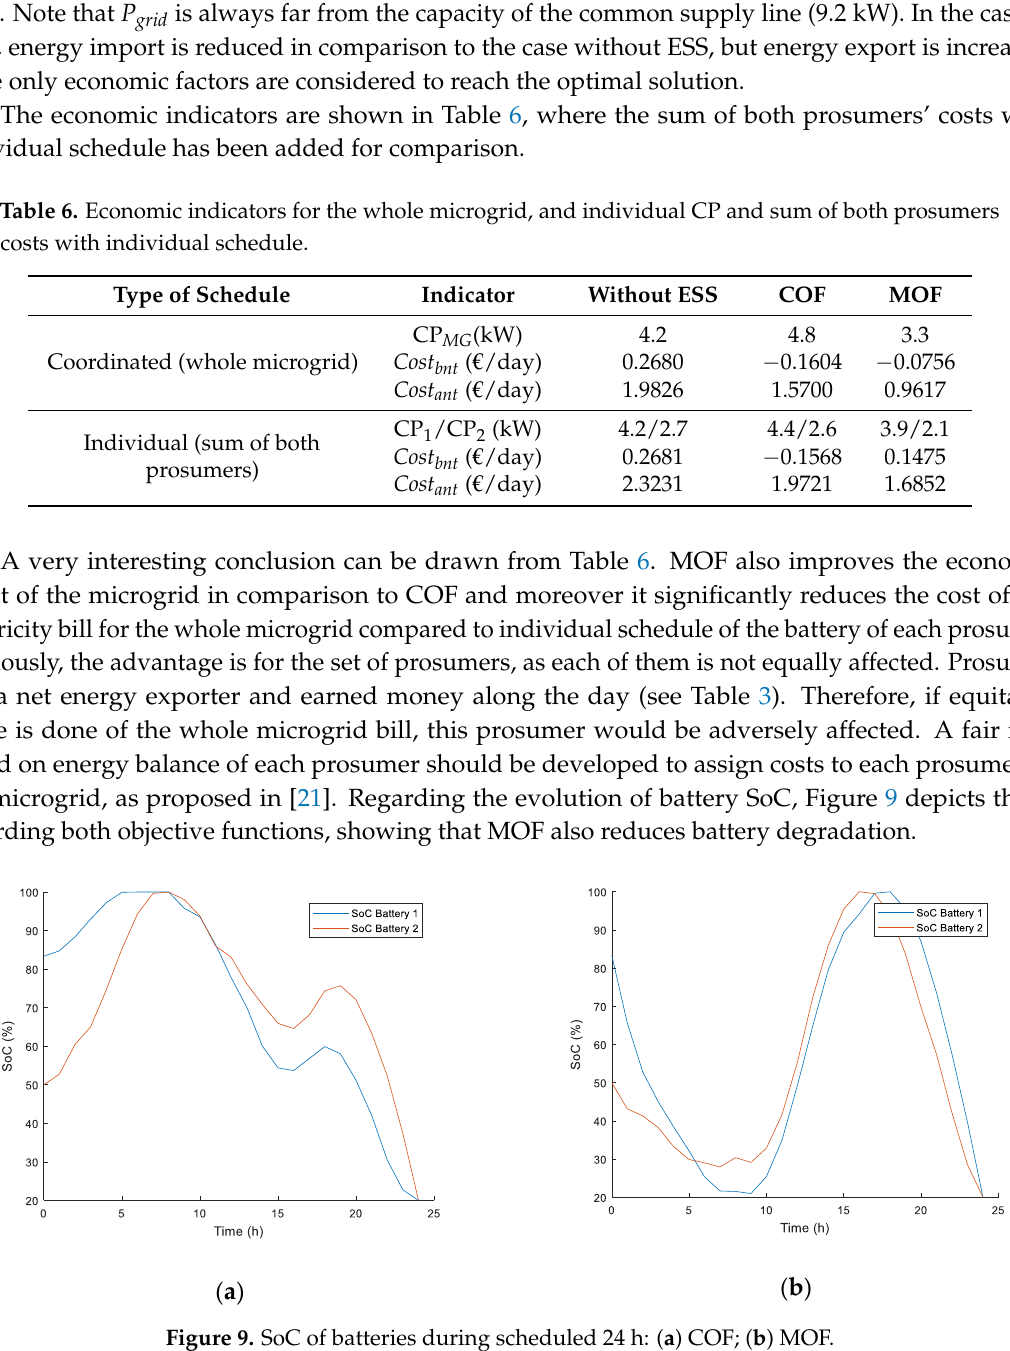
Figure 9. SoC of batteries during scheduled 24 h: ( a ) COF; ( b ) MOF.